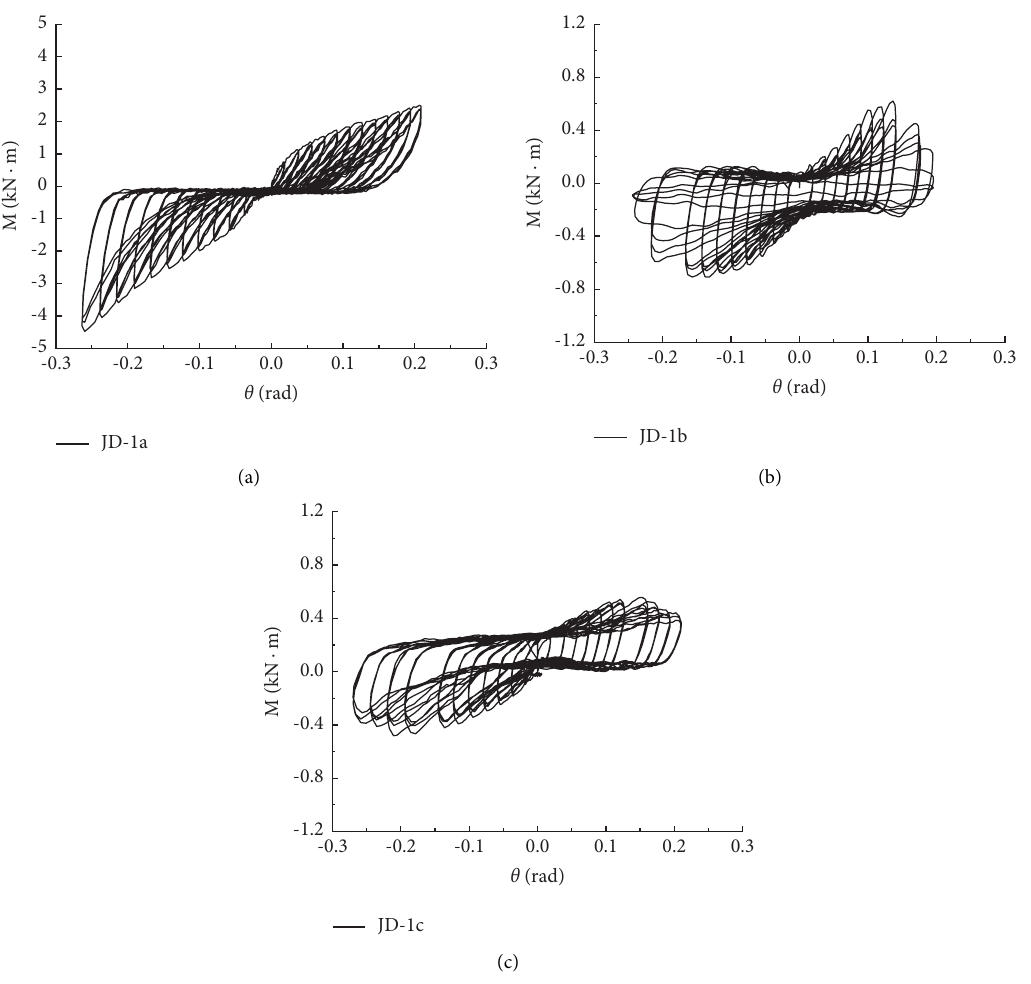
Figure 8: Moment-rotation hysteretic loops before reinforcement: (a) Tou mortise-tenon joints. (b) Ban mortise-tenon joints. (c) Dovetail mortise-tenon